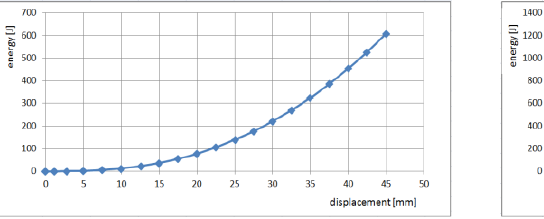
Fig.3 Simple steel panel - model 1 Fig.4 Stiffened steel panel – model 2